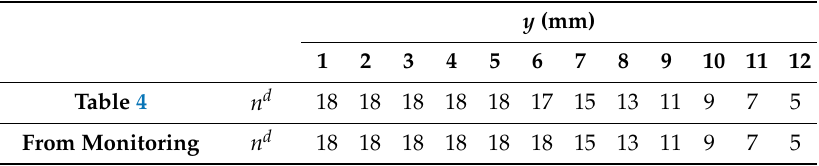
Table 19. Comparison between n d from di ff erent sources in